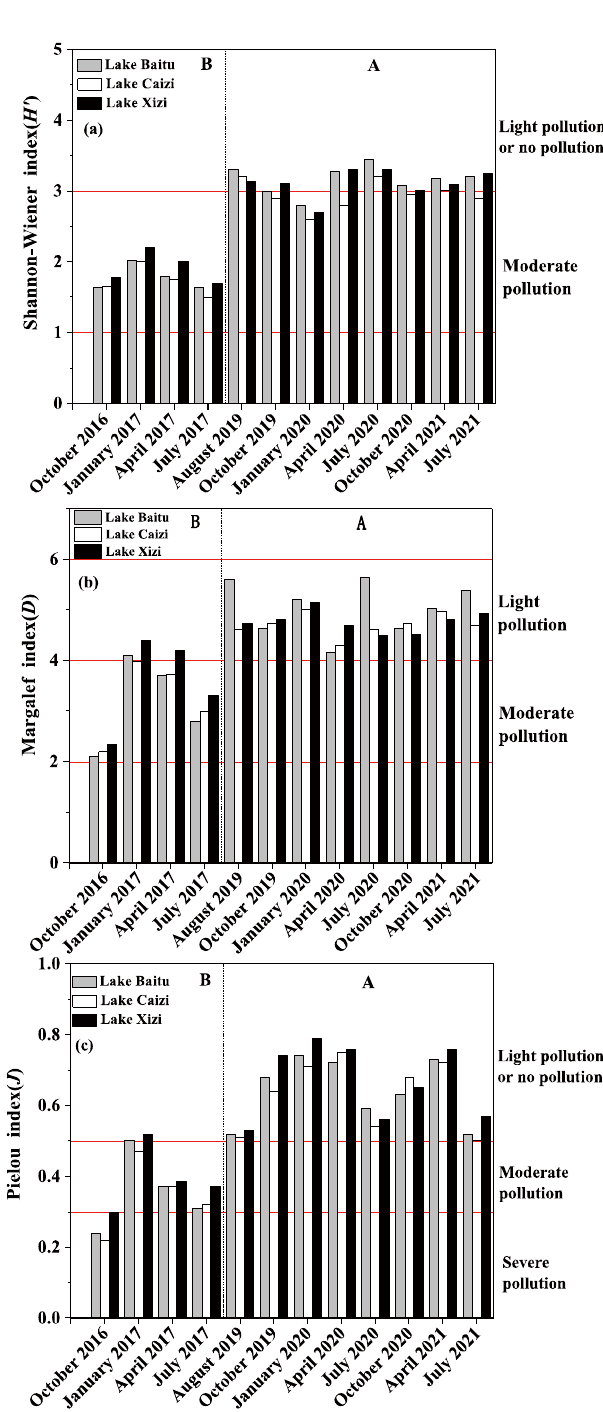
Figure 8. Temporal and spatial variation of the phytoplankton diversity index. Panels ( a – c ) repre- sented the Shannon–Wiener diversity index of phytoplankton, the Margalef index and the Pielou index, respectively. Capital letters B and A represented the before and after restoration of aquatic vegetation, respectively. Vertical lines separated the period before (October 2016 to July 2017) and after (August 2019 to July 2021) recovery. According to the diversity index, the nutrient level of lakes was judged and distinguished by red lines. In Figure a, when H is between 1 and 3, it is moderate pollution, and when H is greater than 3, it is light pollution or no pollution. In Figure b, when D is between 2 and 4, it is moderate pollution, and when D is between 4 and 6, it is light pollution. Figure c When J is between 0 and 0.3, it is severe pollution, between 0.3 and 0.5, it is moderate pollution, and greater than 0.5, it is light pollution or no